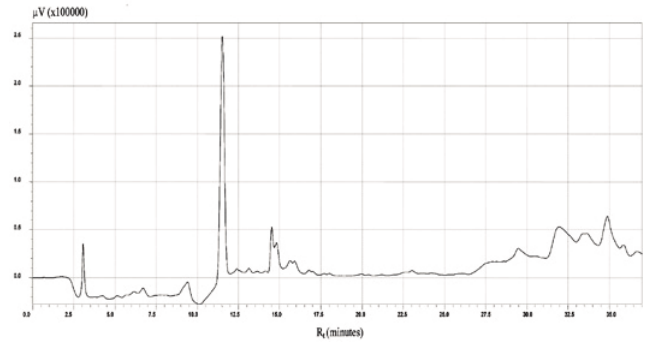
FIGURE 1 - HPLC chromatogram of the broccoli extract.